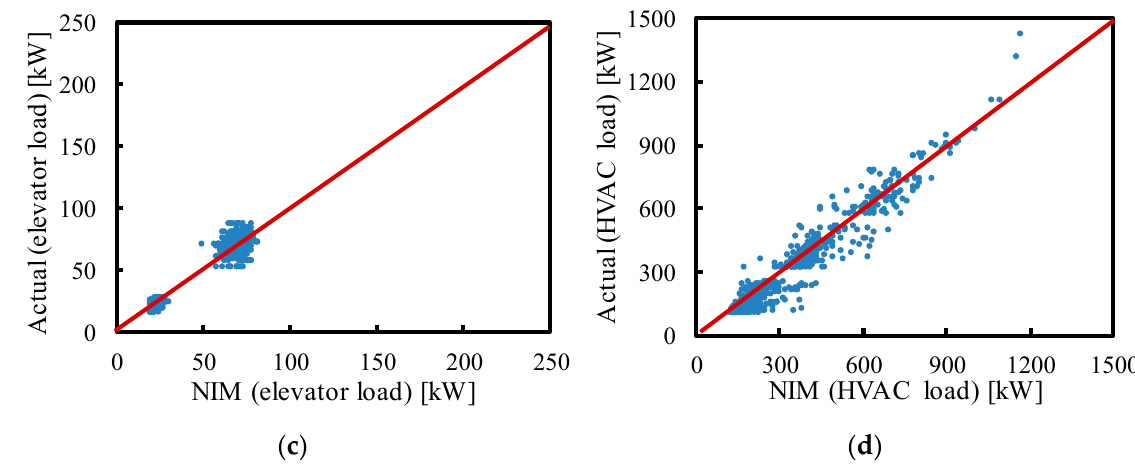
Figure 7. Testing results of the NIM model based on Approach II: ( a ) the comparison results of lighting system load; ( b ) the comparison results of plug-in system load; ( c ) the comparison results of elevator system load; ( d ) the comparison results of HVAC system load.